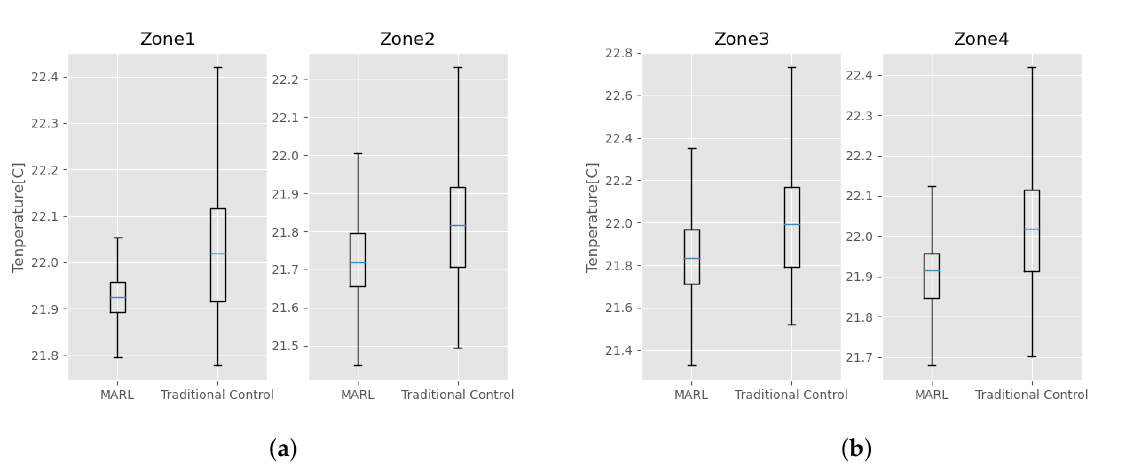
Figure 11. Boxplots of temperature distribution in ( a ) zone 1, zone 2, ( b ) zone 3, and zone 4 in the four-zone UFH system for the MARL simulation and the simulation with a traditional control policy.